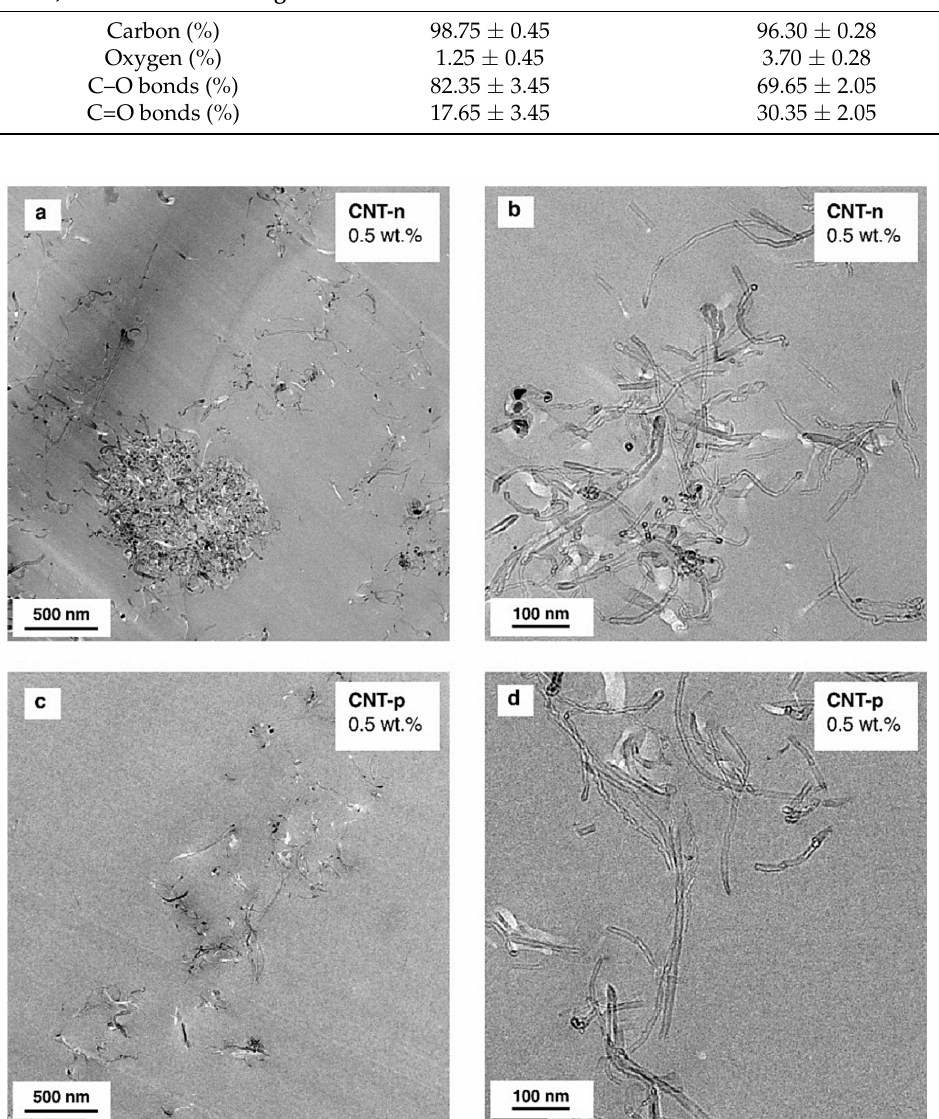
Figure 4. TEM micrographs of neat MWCNT (CNT-n) ( a , b ) and plasma-treated MWCNT (CNT-p) ( c , d ) nanocomposites. CNT content is 0.5